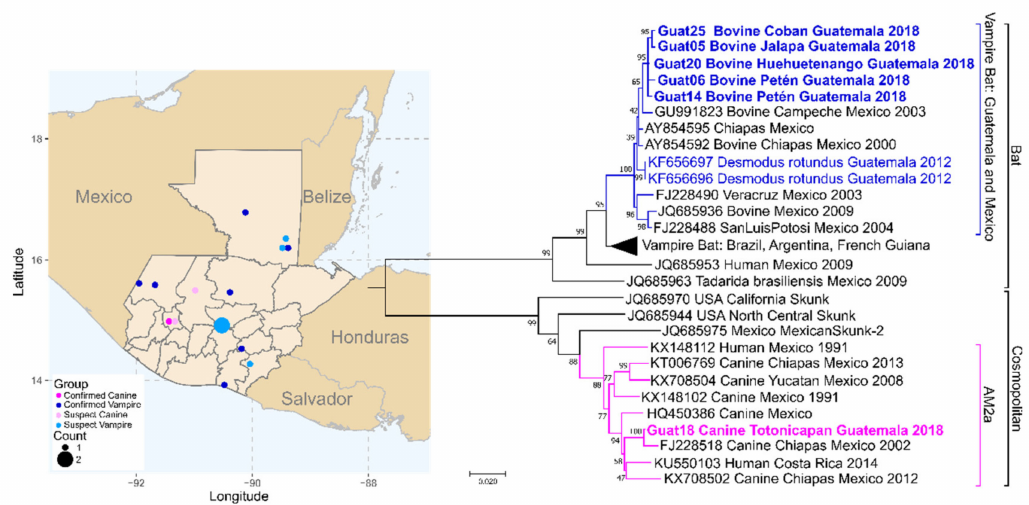
Figure 4. Phylogenetic analysis of MinION sequences generated in Guatemala City, Guatemala. Complete nucleoprotein gene sequences from Guatemala rabies virus isolates were compared to publicly available sequences. Reference sequences were chosen based on sequence similarity to the new Guatemala sequences, isolation from vampire bat or bovine in Mexico or Guatemala, or inclusion Cosmopolitan Americas-2a (AM2a) rabies phylogenetic clade based on Troupin et al. [31]. Accession number, host animal, location, and collection year are included for reference, when available. Sequences generated in this study are highlighted in bold; additional information can be found in Table S1. Colored points on the map correspond to the location of LN34 positive samples; confirmed canine or vampire bat lineage isolates are colored dark blue or dark pink on the map and phylogenetic tree. Suspected lineage was based on host (canine or bovine). Phylogenetic analysis was performed by maximum likelihood based on the GTR + G + I model in Mega7. Number of changes per site is shown along the horizontal axis. Bootstrap values near the branch points represent the percentage of trees that had the same clustering out of 1000